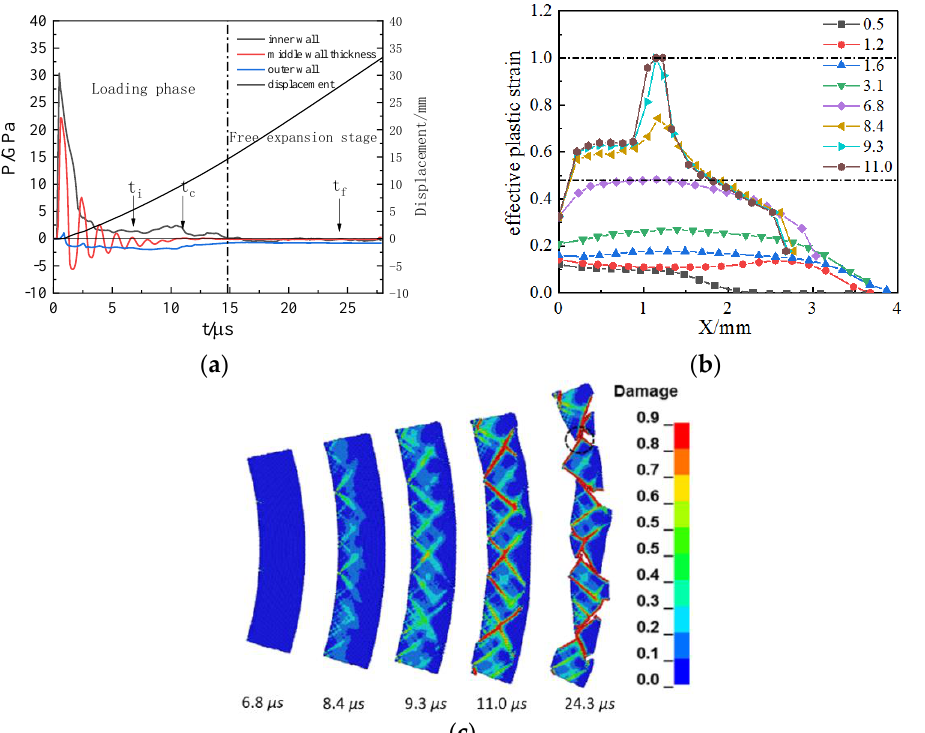
Figure 10. The explosive pressure, expanding deformation, and fracture for 45 steel cylinder shell under RHT − 901 loading: ( a ) detonation wave propagation curves; ( b ) development of effective plas- tic strain in the shell thickness; ( c ) damage evolution for fracture.